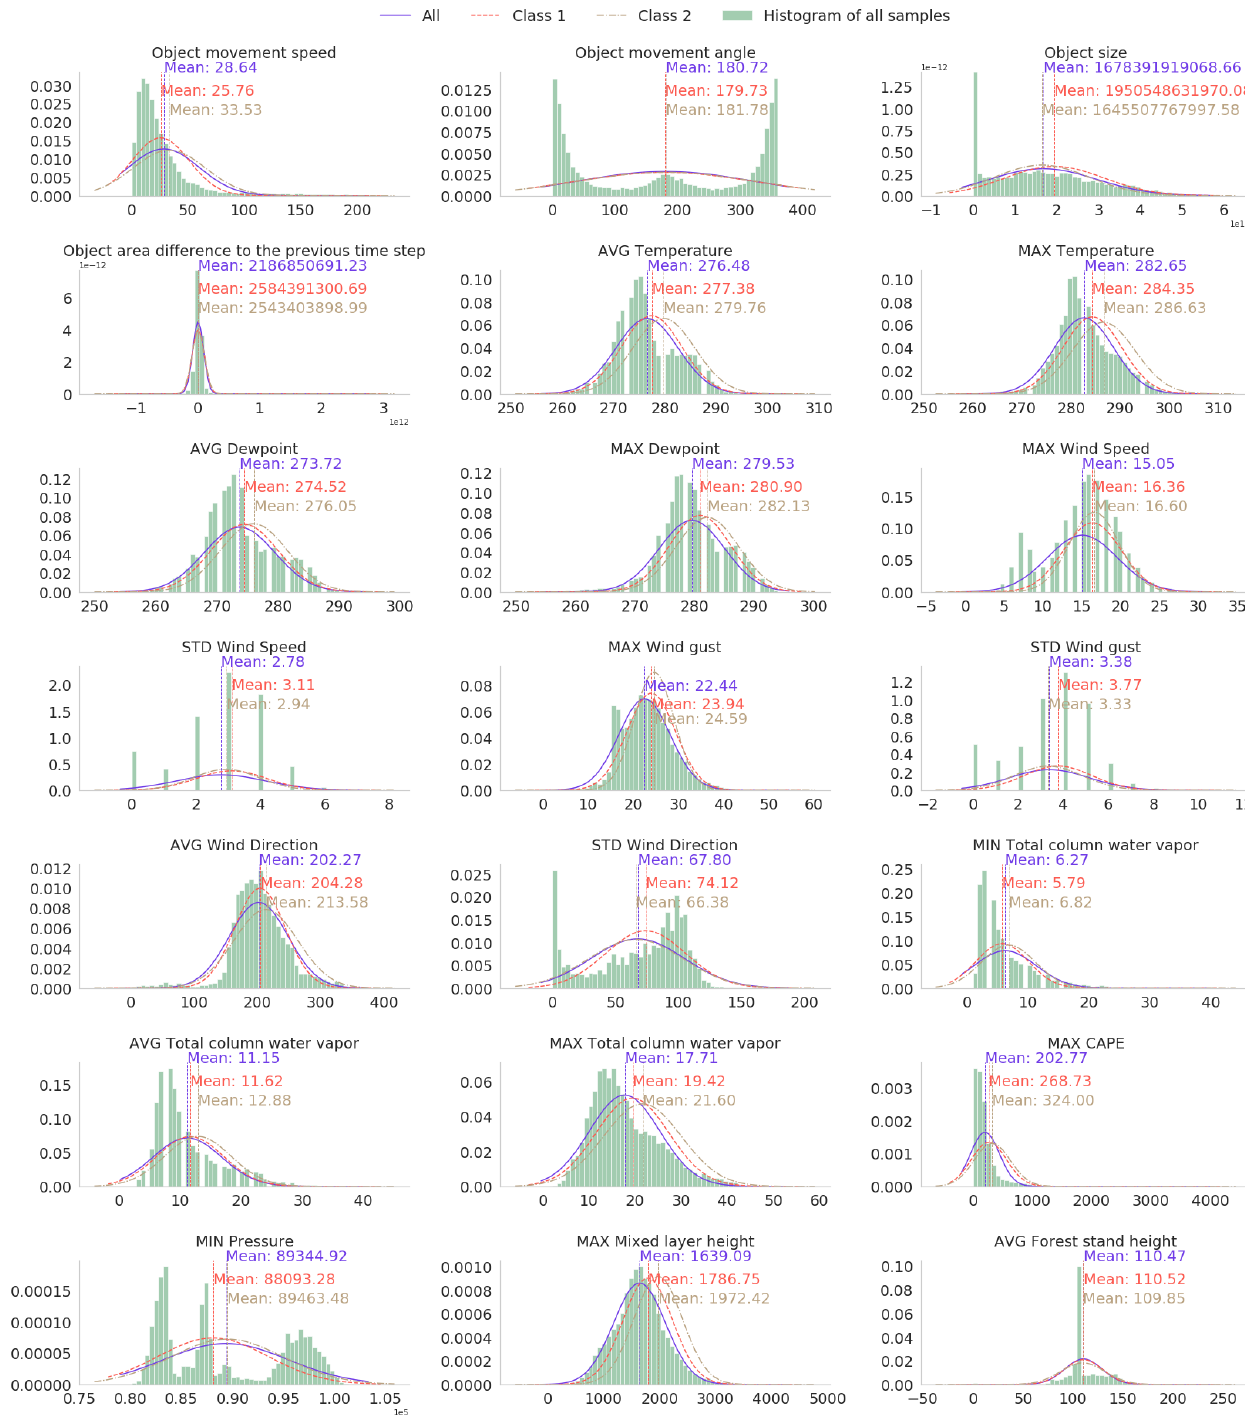
Figure A1. Histogram of and fitted Gaussian distribution of selected predictive parameters in the local dataset. The Gaussian distribution is fitted separately to all samples and samples with little outages and many outages (classes 1 and 2 specified in Sect.